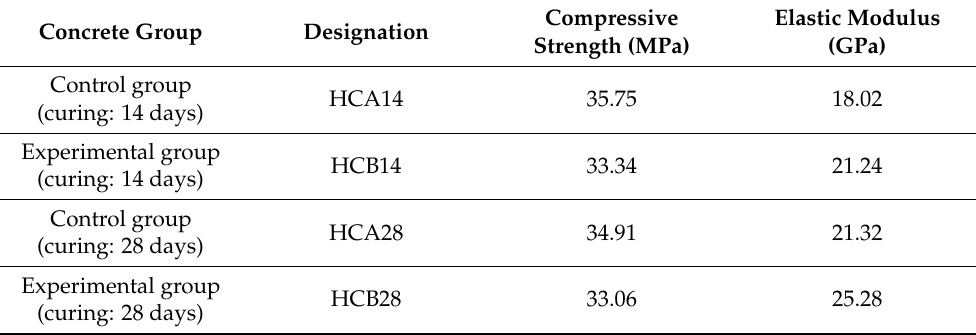
Table 14. Test results of compressive strength and elastic modulus of the self-healing concrete after exposure to high